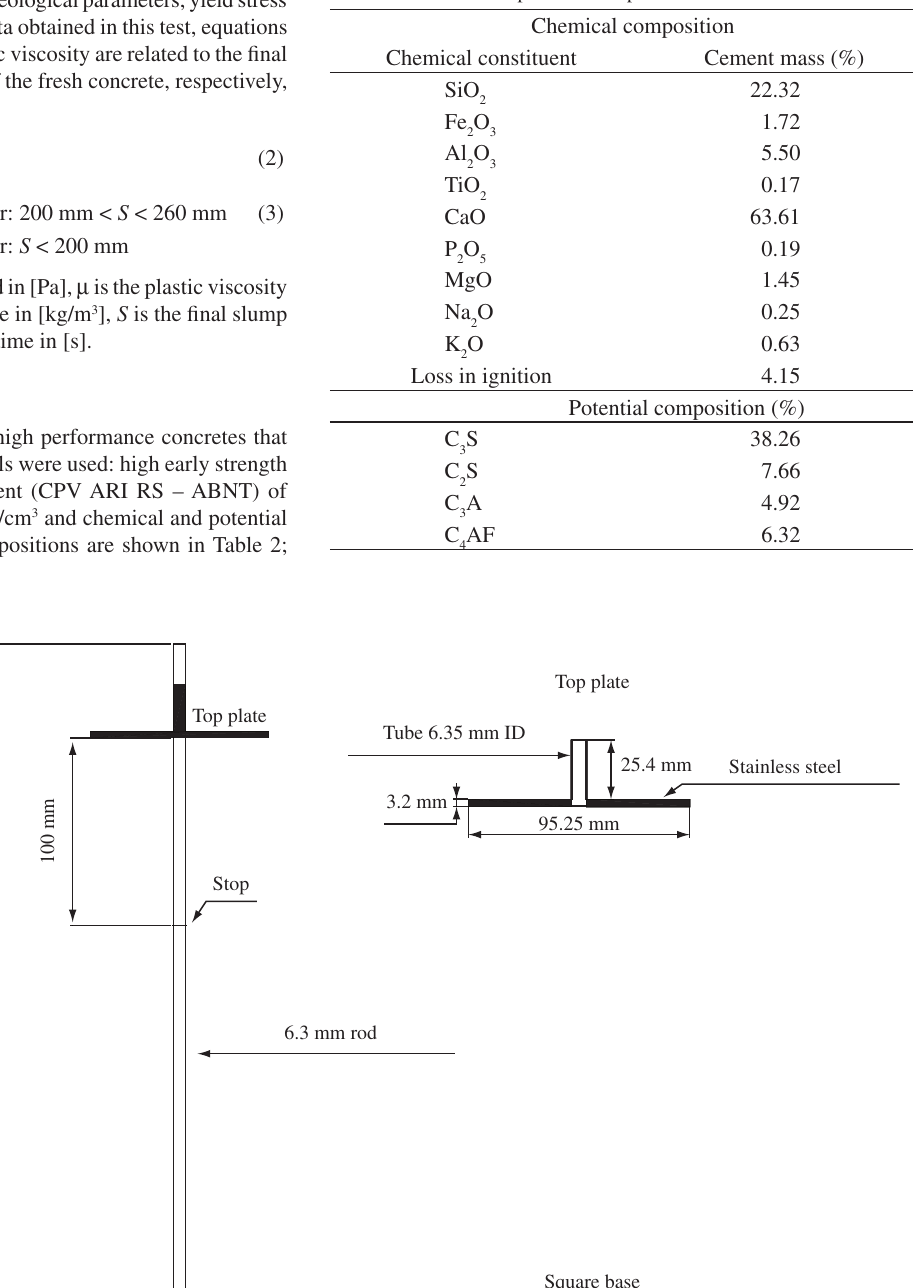
Table 2. Chemical and potential compositions of used